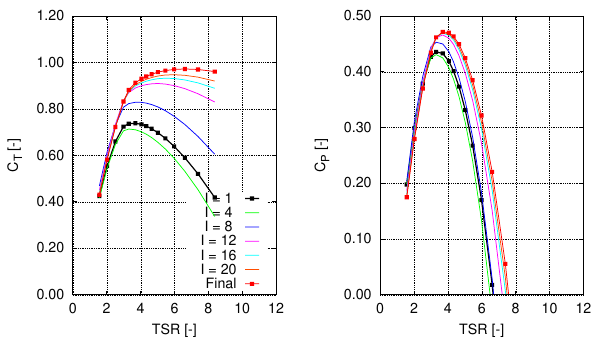
Fig. 12. Model turbine: thrust (left) and power (right) coefficient curves during iteration, λ des = 3 . 0 .